Question: Describe this figure in one sentence.
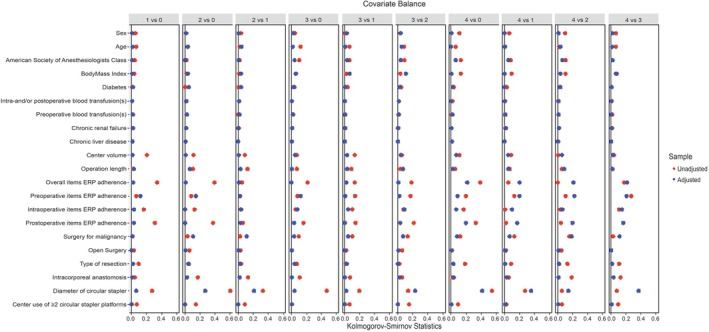
Answer: Love plot of covariate balance before and after adjustment using generalized boosted models. Love plot displaying Kolmogorov–Smirnov statistics for baseline covariates across pairwise comparisons of the five circular stapler platforms included in the study. Platform 1 (3‐row circular stapler), labelled as group “0” in the figure, served as the reference category and was compared with Platform 2 (2‐row circular stapler, “1”), Platform 3 (2‐row circular stapler, “2”), Platform 4 (2‐row powered circular stapler, “3”) and Platform 5 (2‐row circular stapler, “4”). Red dots indicate unadjusted comparisons, whereas blue dots indicate comparisons after generalized boosted model weighting. Improved covariate balance after adjustment is reflected by lower Kolmogorov–Smirnov statistics. ERP, Enhanced Recovery Pathway.